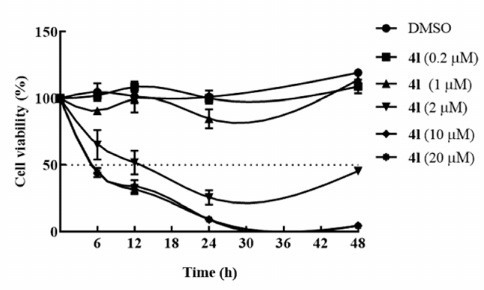
Figure 3. The growth curve of compound 4l on K562 cells at 6, 12, 24, 28 h, cell viability was defined as 100% at 0